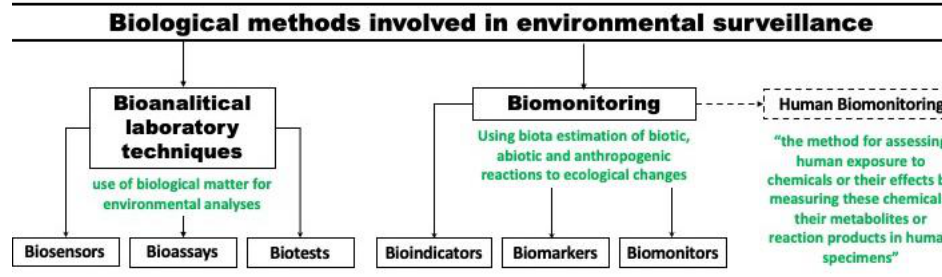
Figure 1. Biological methods of environmental studies.